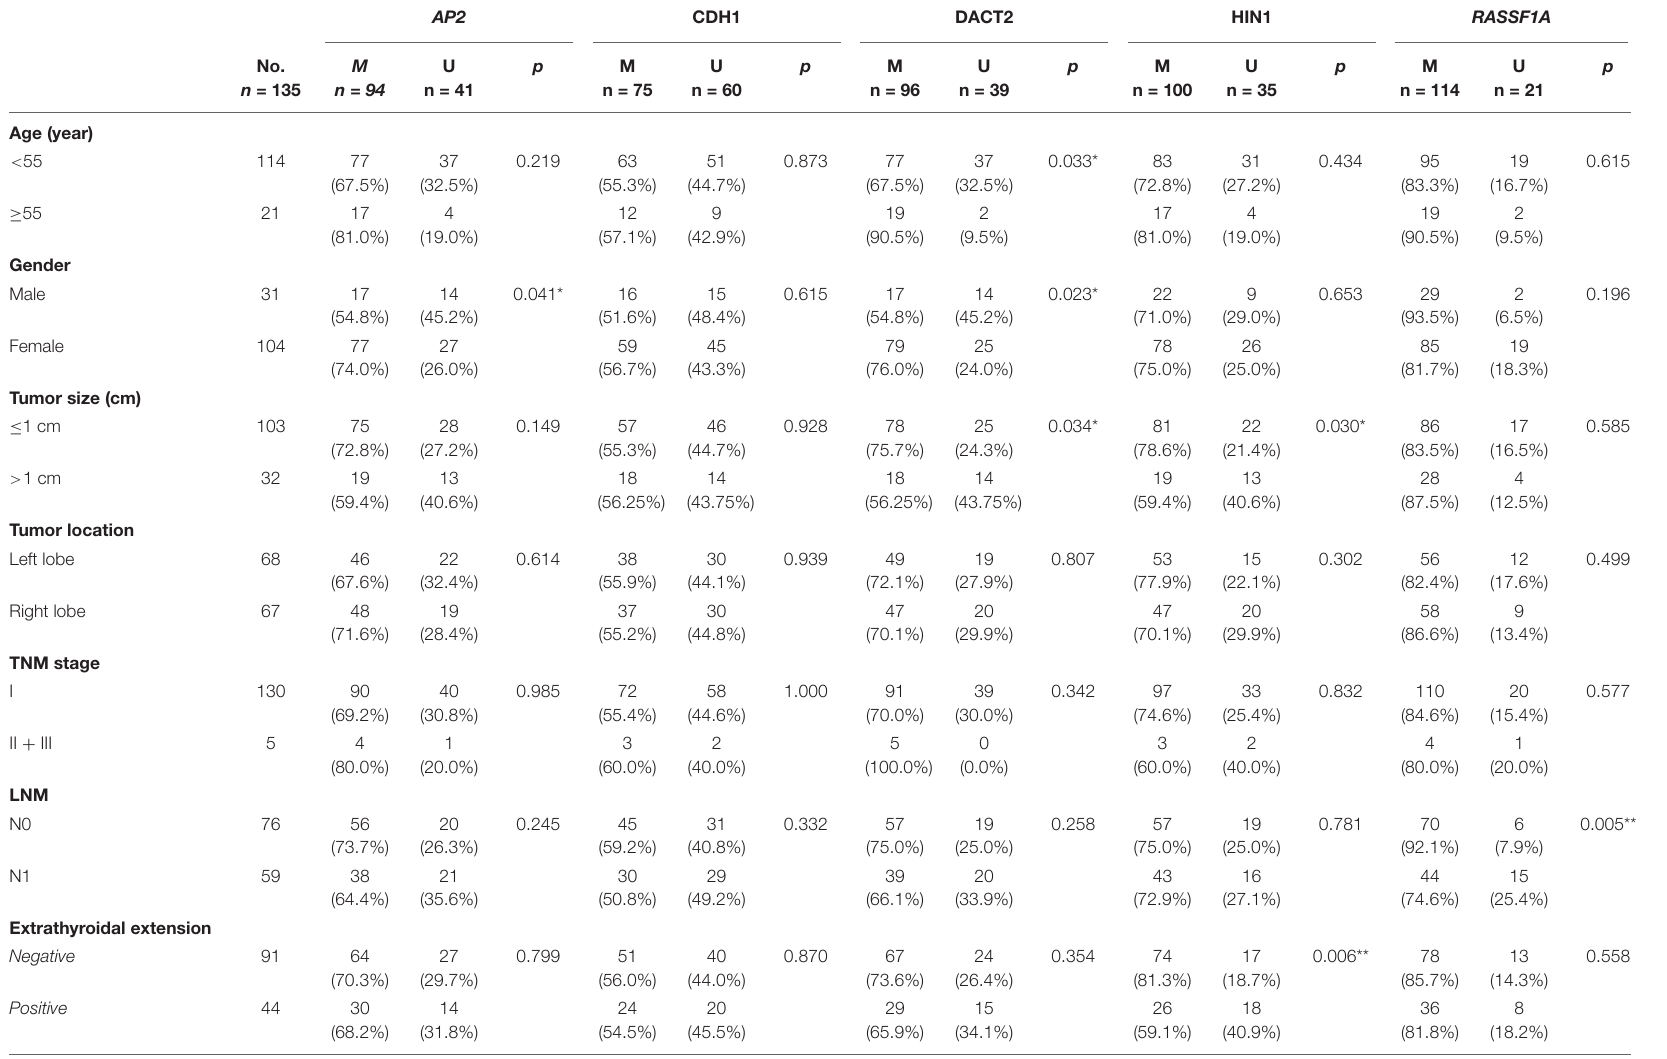
TABLE 2 | The association of gene methylation and clinical factors in validation